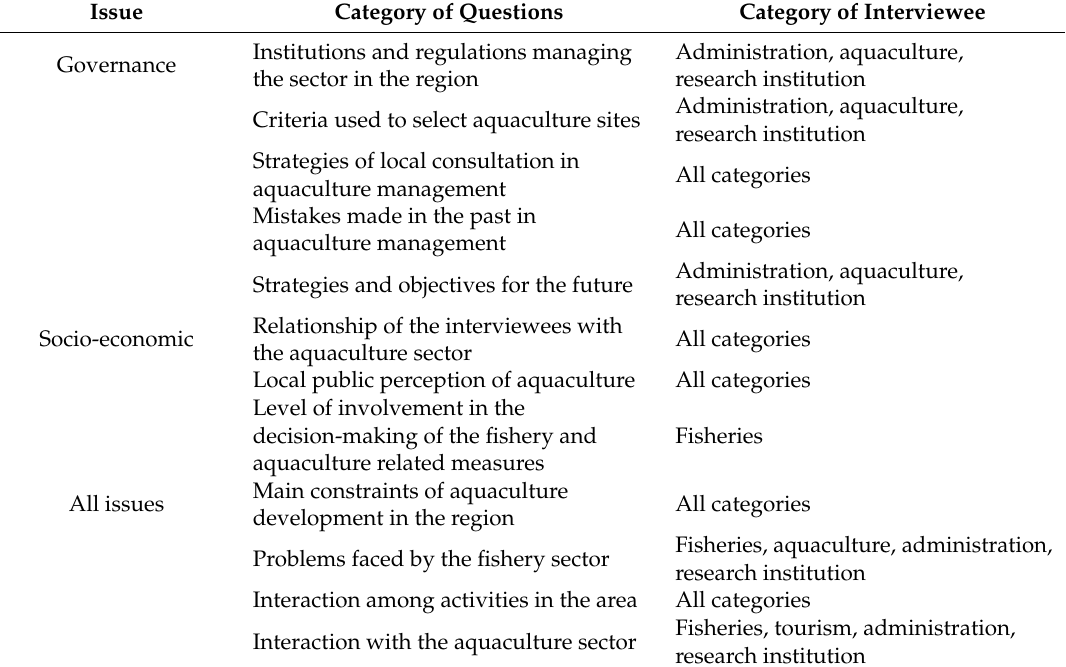
Table 2. The main issues explored in the semi-structure interview and categories of